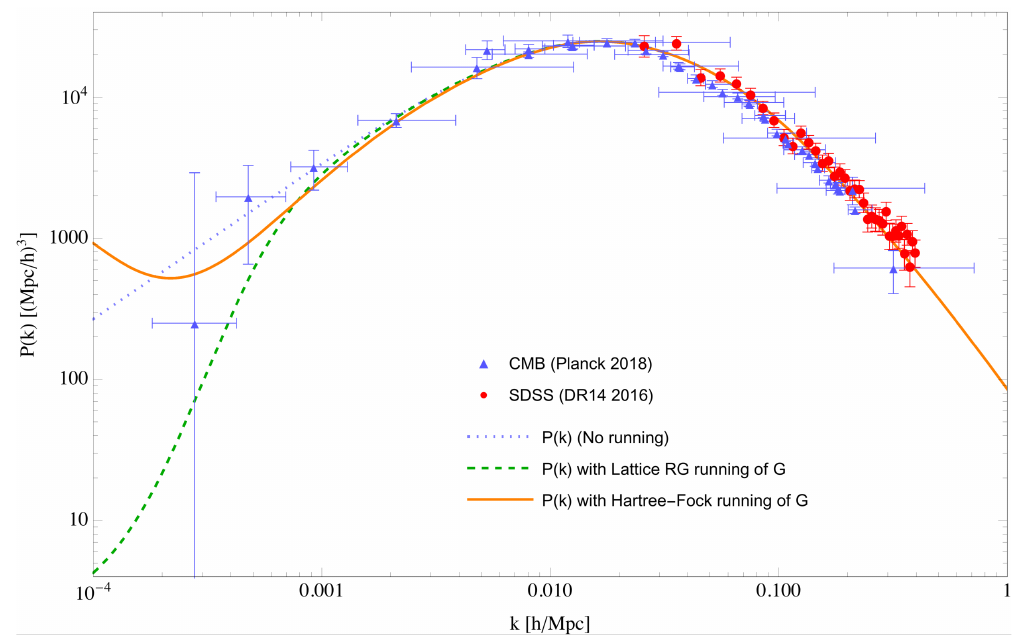
Figure 5. Lattice versus Hartree-Fock running of Newton’s constant G . The middle solid (orange) curve shows P ( k ) implemented with the Hartree-Fock running of Newton’s constant G factor. The lower dashed (green) curve shows the original lattice RG running of Newton’s constant G (with the original lattice coefficient 2 c 0 = 16.04) for comparison. The original spectrum with no running is also displayed by the top dotted (blue) curve for